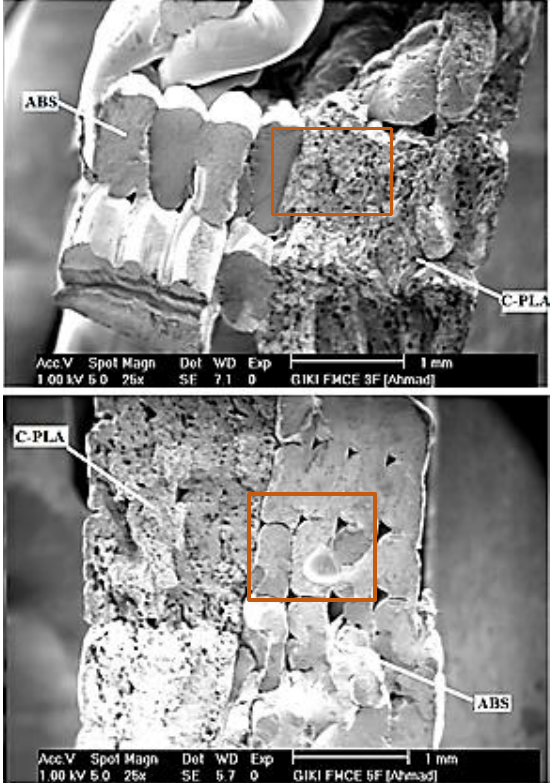
Figure 8. SEM images of cross sections of fractured sample 3 and sample 5.